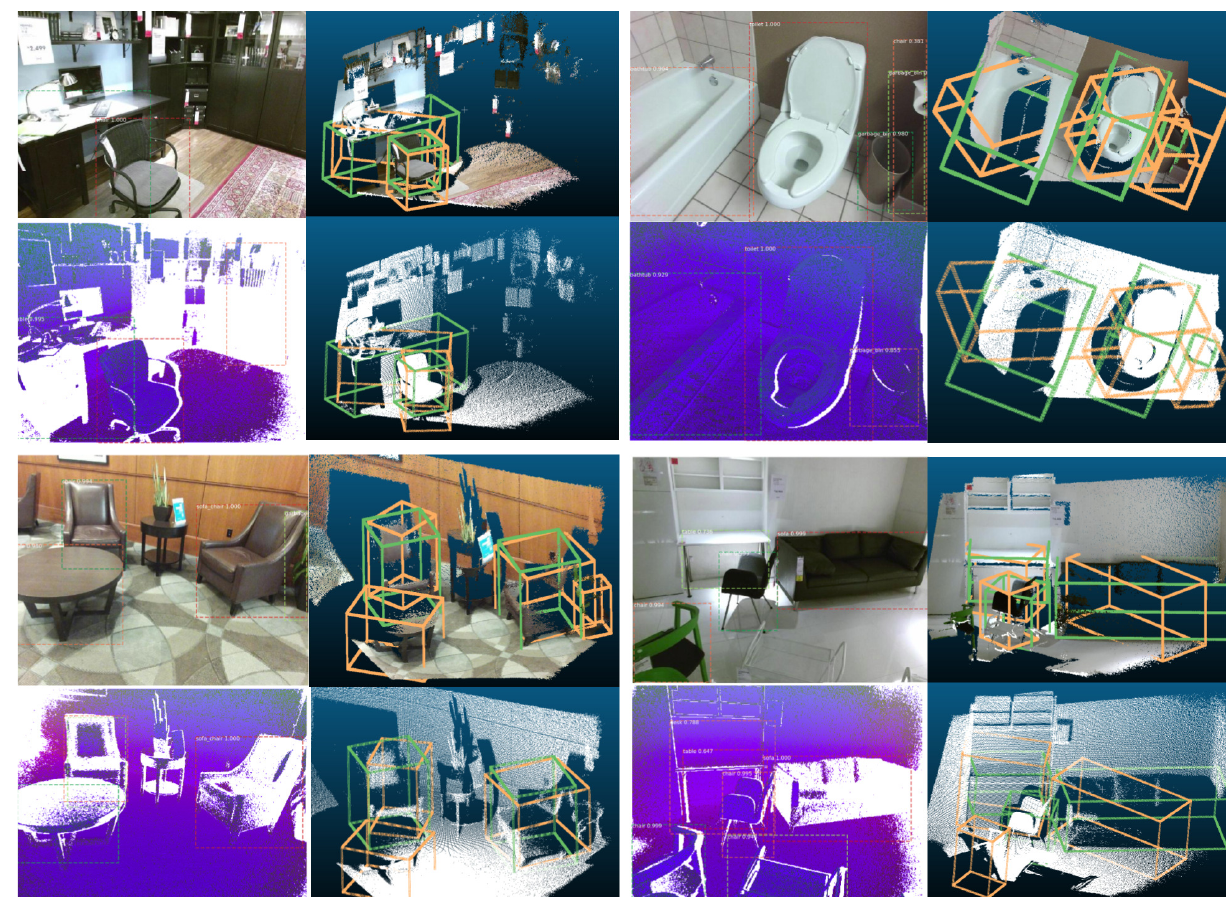
Figure 12. Visualizations of 2D and 3D detection results part 1. This visualization contains four RGB images and four DHS images. For each image, 2D detection is shown superimposed. Next to each image we show the corresponding 3D detection results (light green ones are the 3D ground truth boxes and orange-colored boxes are the predictions) based on frustums generated from image 2D detections (to have a better visualization, RGB colors are projected back to the cloud